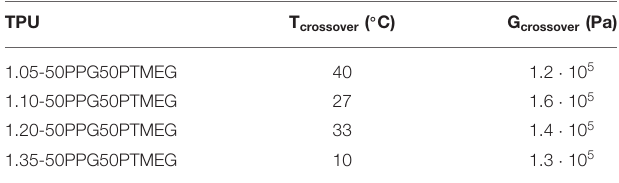
TABLE 3 | Values of temperature and modulus at the crossover of G ′ and G ′′ of the TPUs synthesized with 50 wt% PPG + 50 wt% PTMEG blend and different NCO/OH